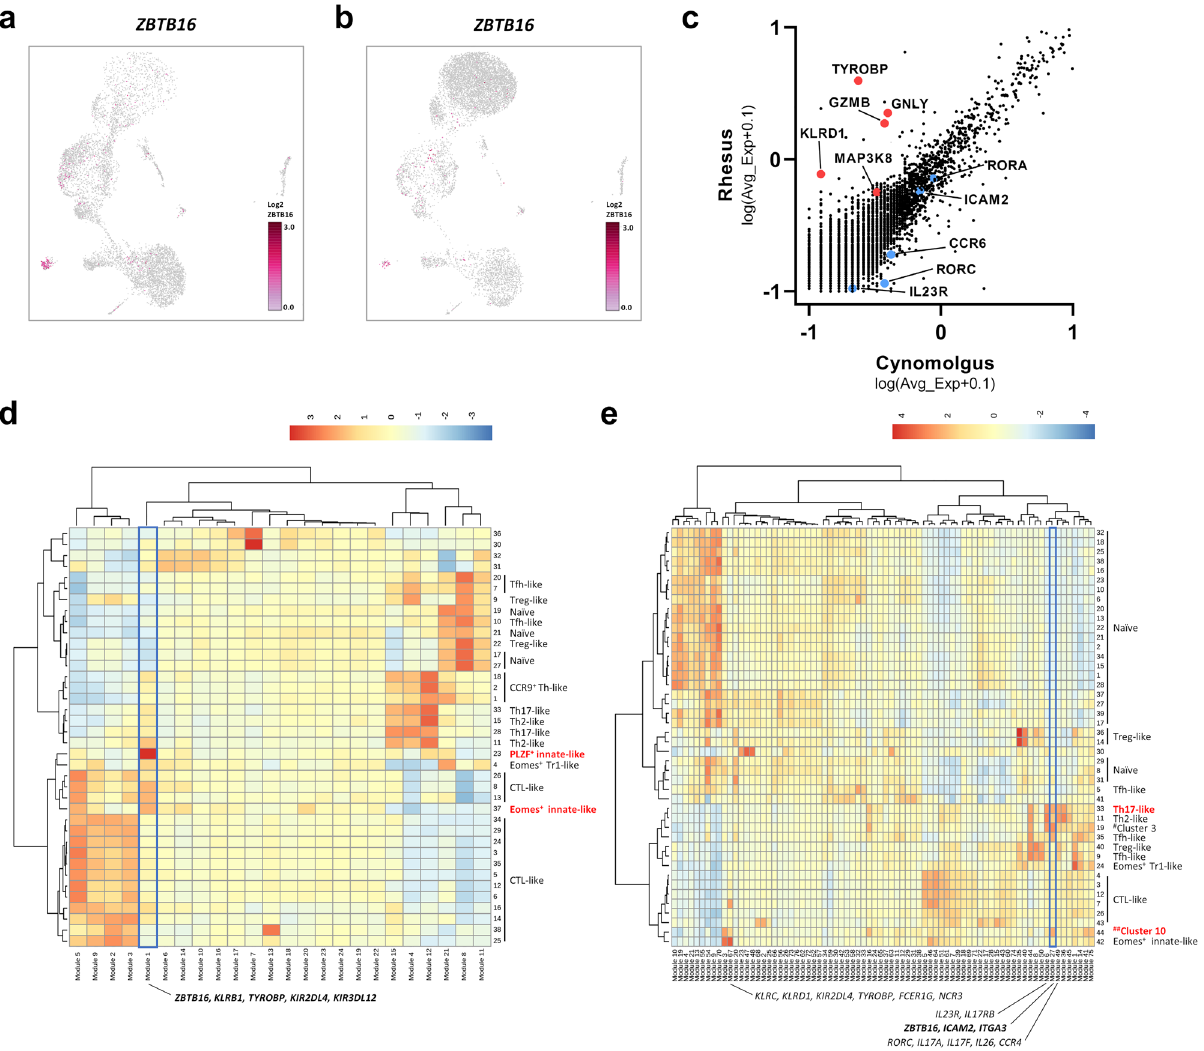
Figure 4. ( a, b ) UMAP representing the expression of ZBTB16 (PLZF) in ( a ) the rhesus monkey and ( b ) the cynomolgus monkey. ( c ) Scatter plot showing differentially expressed genes between ZBTB16 + clusters from the rhesus and the cynomolgus monkey. ( d ) Heatmap showing aggregate expression of all genes in each module across all clusters detected in the rhesus monkey. ( e ) Heatmap showing aggregate expression of all genes in each module across all clusters detected in the cynomolgus monkey. The cluster number and the defined cell subset corresponding to each cluster are shown on the right side of the heatmap. Representative genes corresponding to the module are shown below the heatmap. Scatter plots were generated using GraphPad Prism 8.0.2. and heatmaps were generated using Monocle3